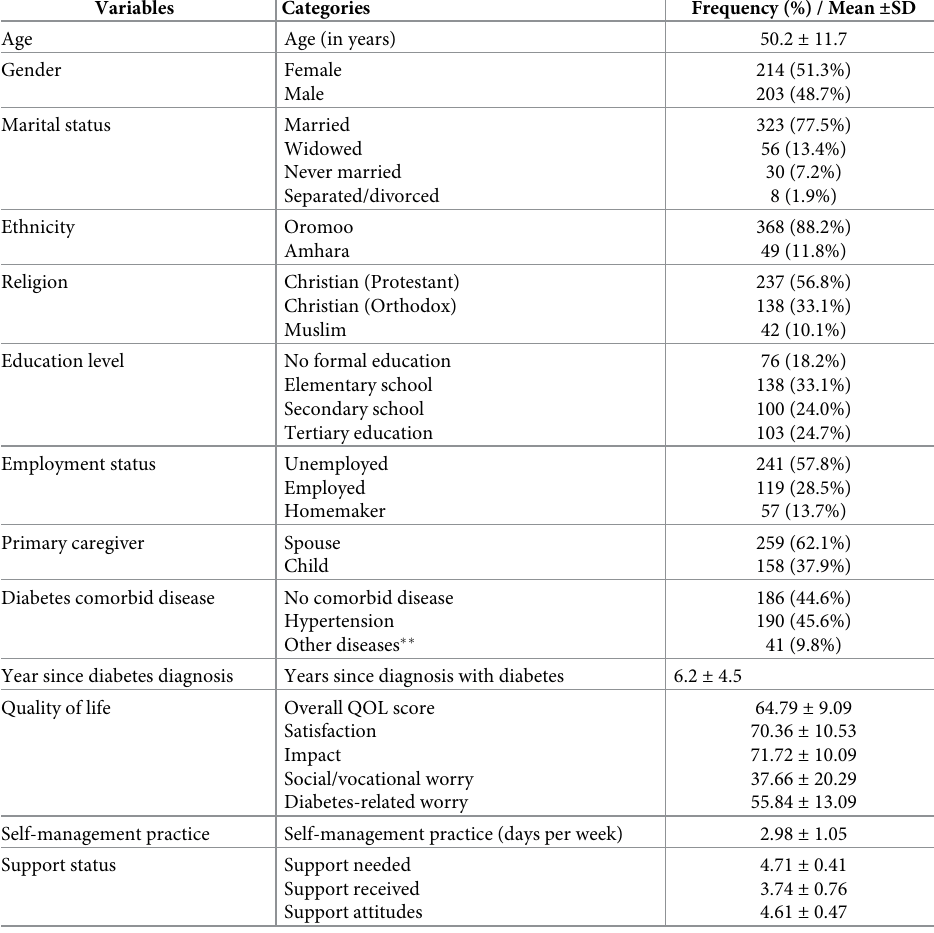
Table 1. Sociodemographic characteristics, quality of life, self-management practice, and support status of the participants (n =